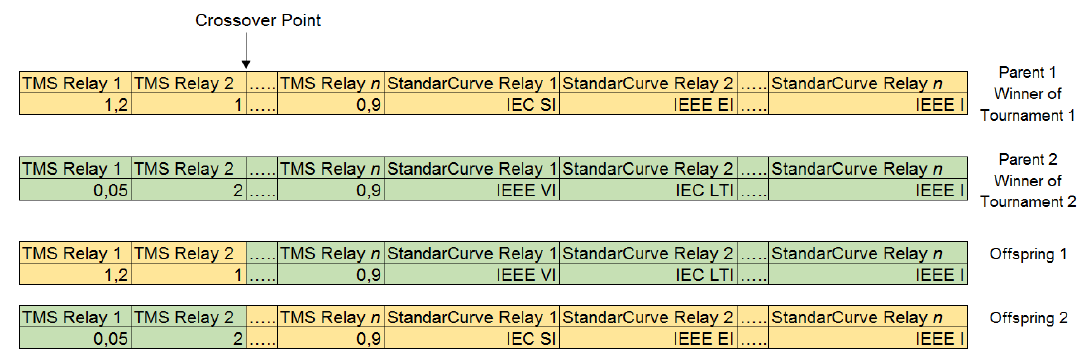
Figure 3. Example of